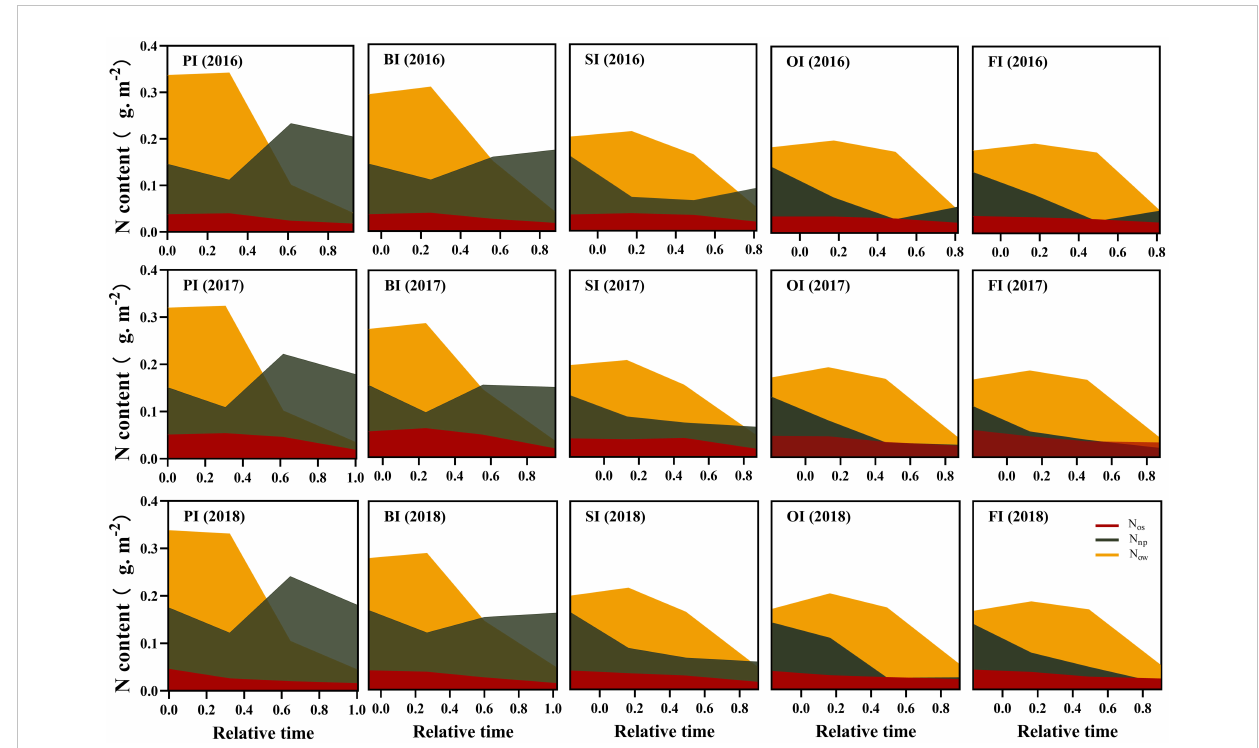
FIGURE 5 Leaf storage N dynamics during the reproductive period. PI and BI represent drip irrigation under plastic fi lm mulch and biodegradable fi lm mulch, respectively; SI, drip irrigation incorporating straw returning; OI, drip irrigation with the tape buried to a shallow soil depth; FI, furrow irrigation. Relative time is the ratio of days after silking to the duration from silking to maturity. N os , SDS-soluble protein storage N. N ow , water-soluble protein storage N. N nop , non-protein storage N. The data in this fi gure are presented in Table S4 for further interpretation.